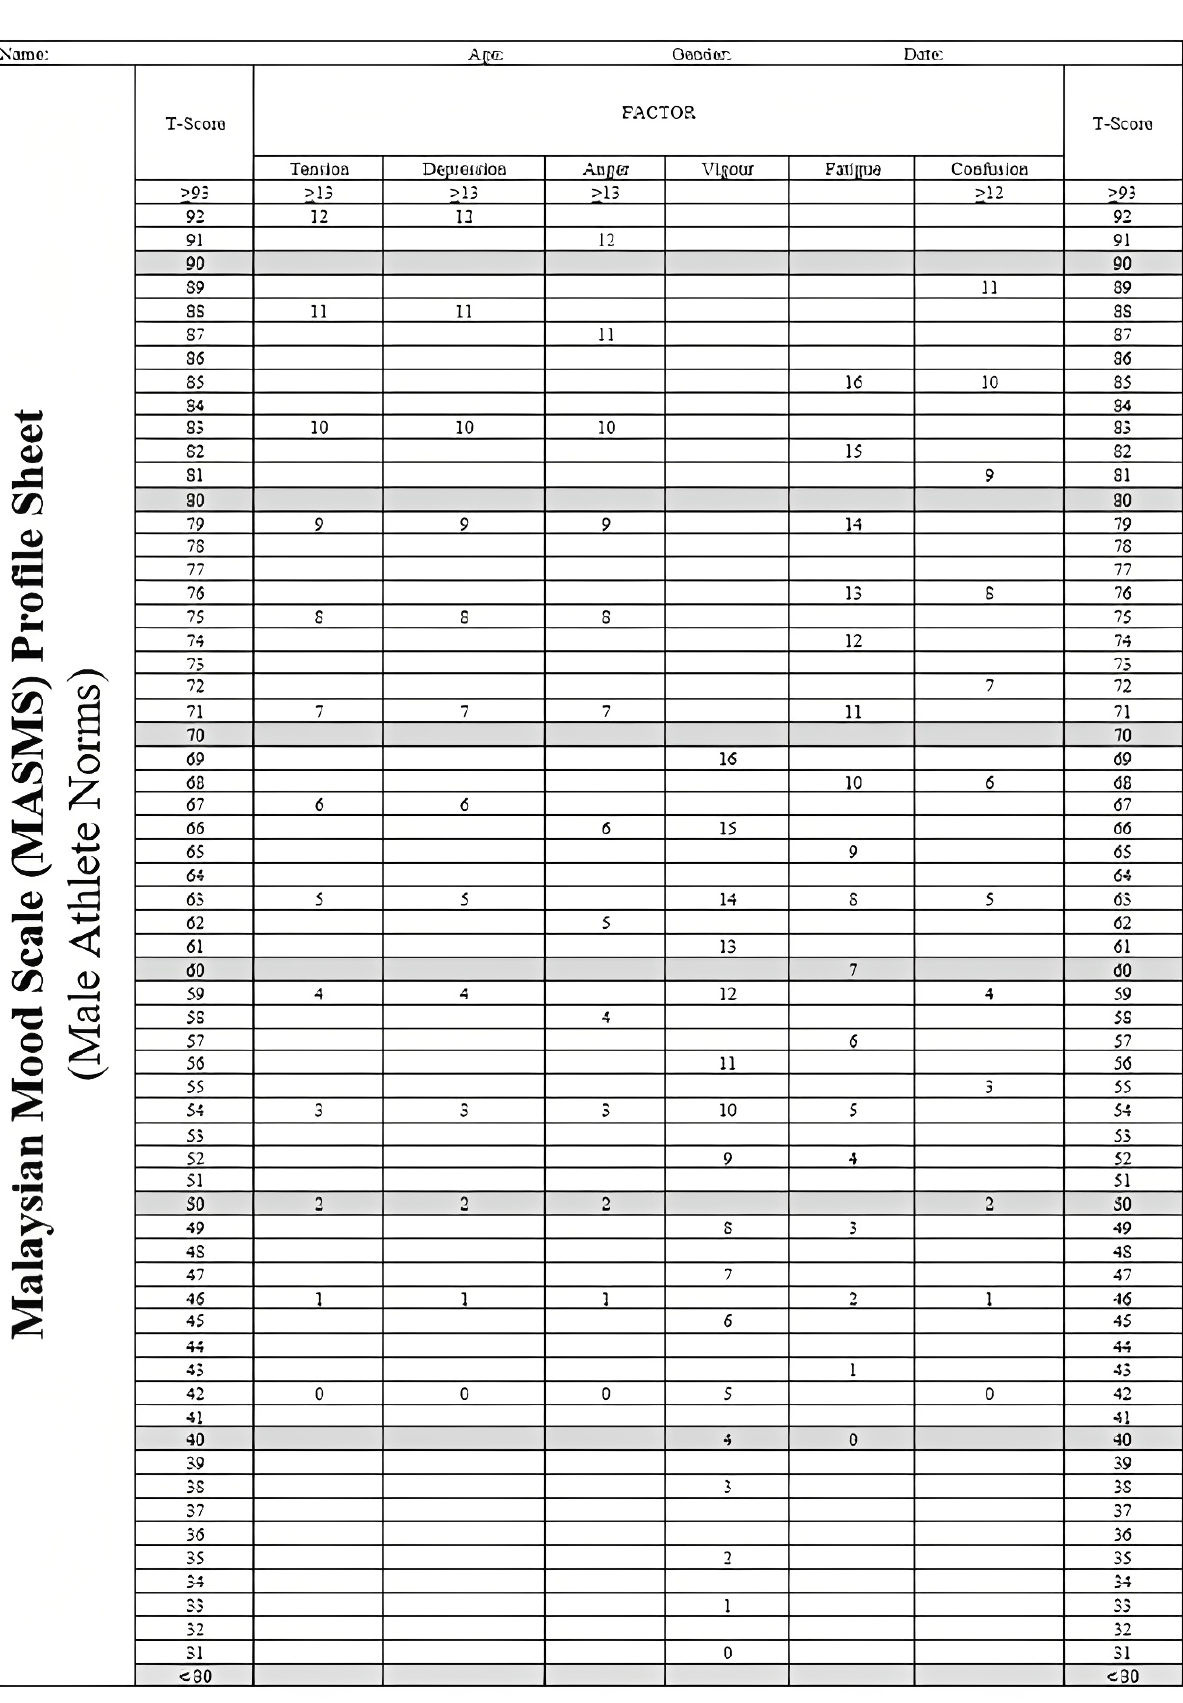
Figure A2. MASMS profile sheet (male athlete norms).